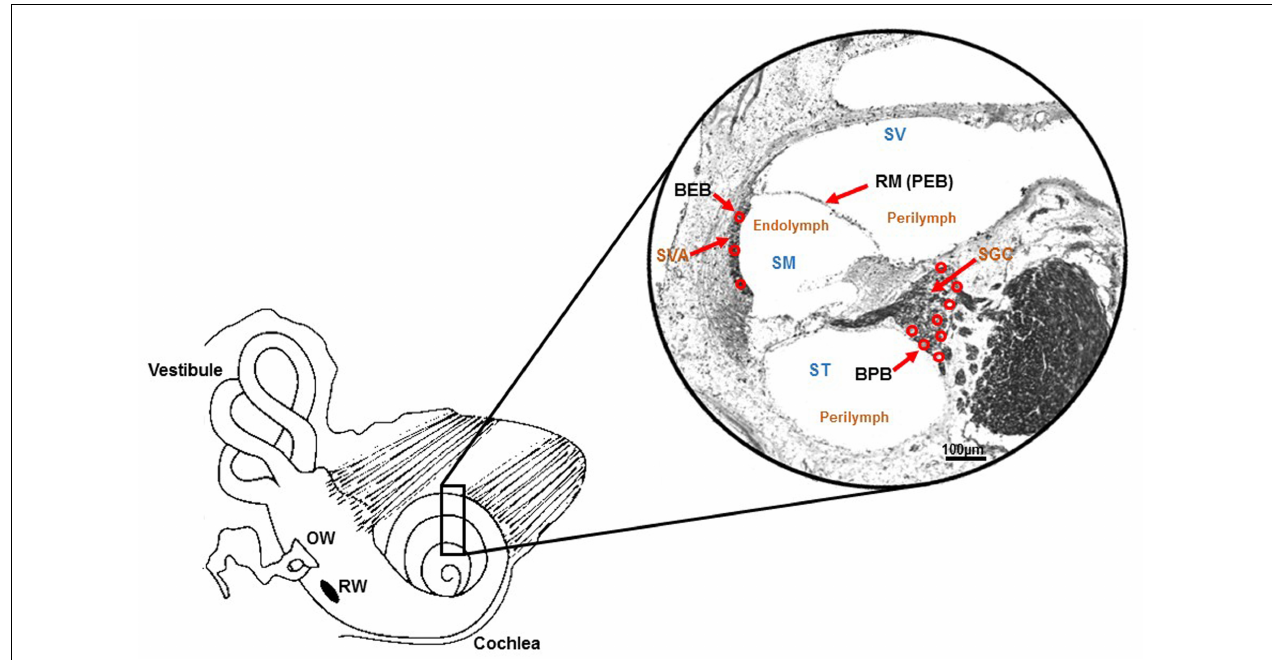
FIGURE 1 | Schematic illustration of barriers within inner ear. Drawing of the cochlea and photomicrograph of a mid-modiolar section of the rat cochlea (stained with Sudan black) demonstrating the various barriers within the inner ear. These include the blood-endolymph barrier (BEB) in the stria vascularis; the blood-perilymph barrier (BPB); and the perilymph-endolymph barrier (PEB) which is formed by Reissner’s membrane (RM). Other abbreviations are: SVA (stria vascularis), SGC (spiral ganglion cells), SV (scala vestibuli), ST (scala tympani) and SM (scala media). Perilymph is contained within SV and ST, and endolymph is present in SM. Adapted from Zou et al. (2016).